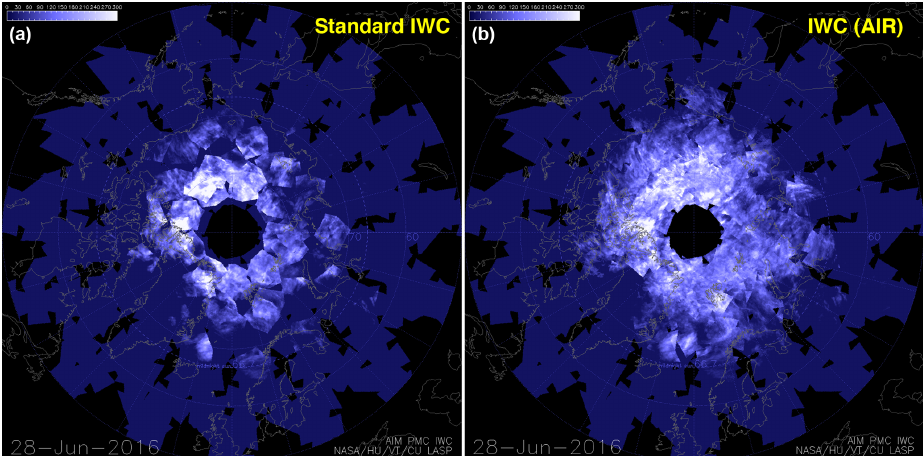
Figure 7. Same as Fig. 6 except for 28 June 2016.